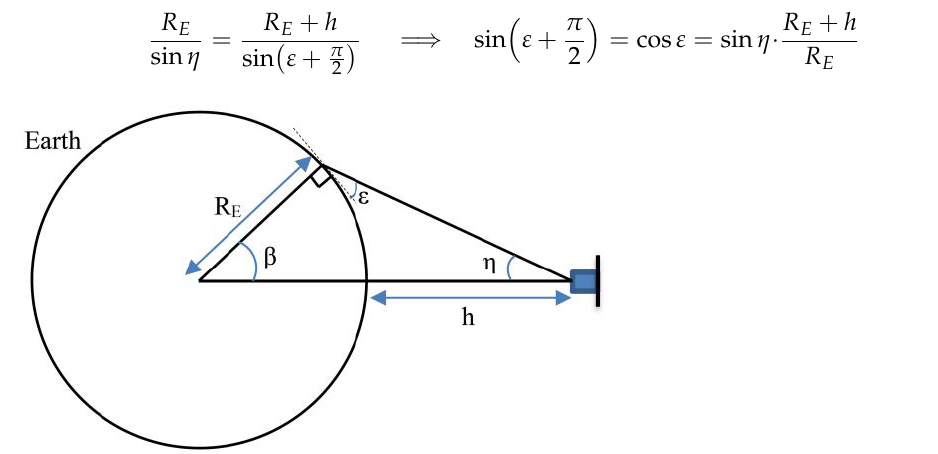
Figure 3. Geometry representation of the sensor FOV assuming spherical Earth with constant ra- dius 𝑅 𝐸